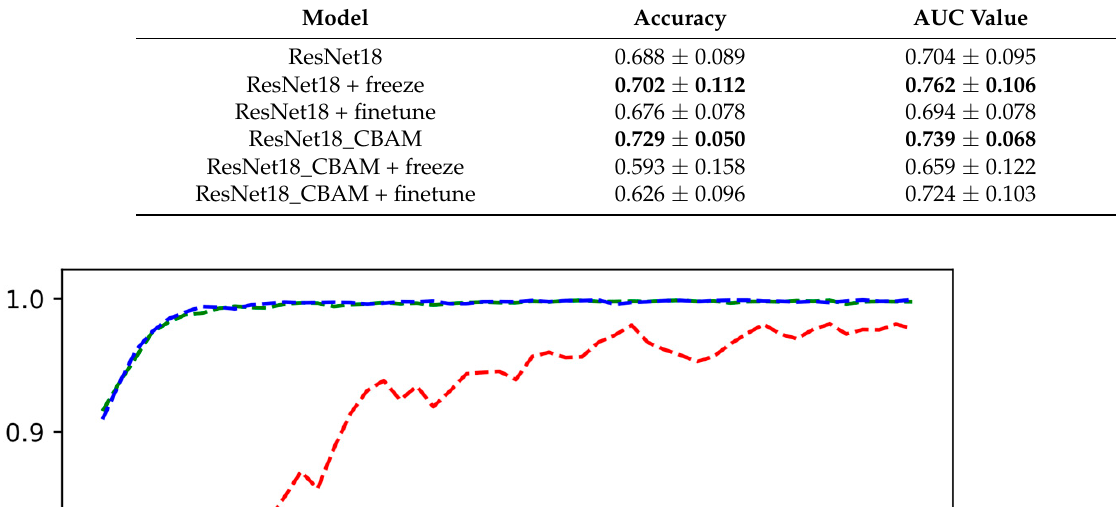
Table 3. Test performance of transfer learning models.